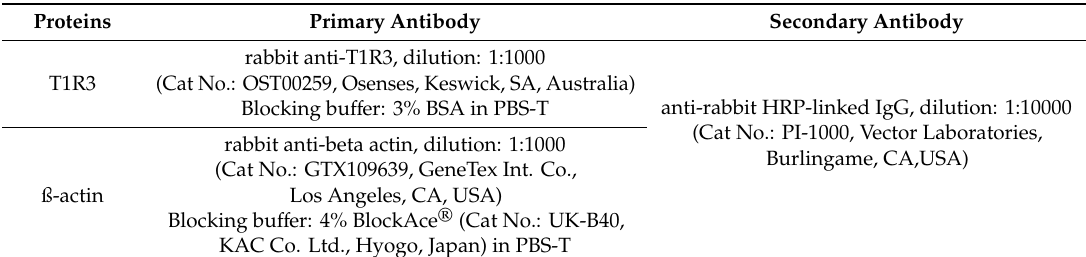
Table 2. Antibodies used for Western blotting.